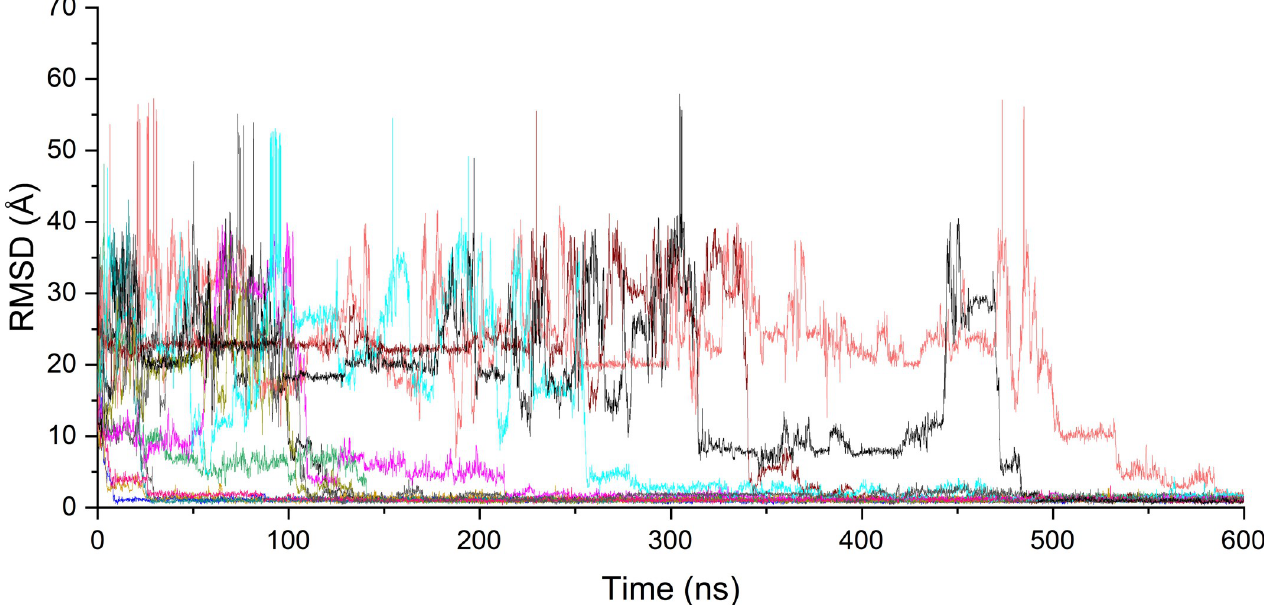
Fig 2. Typical RMSDs of oseltamivir in the trajectories produced binding events. The RMSD of heavy atoms of oseltamivir was calculated by referring those of oseltamivir of the crystal structure.